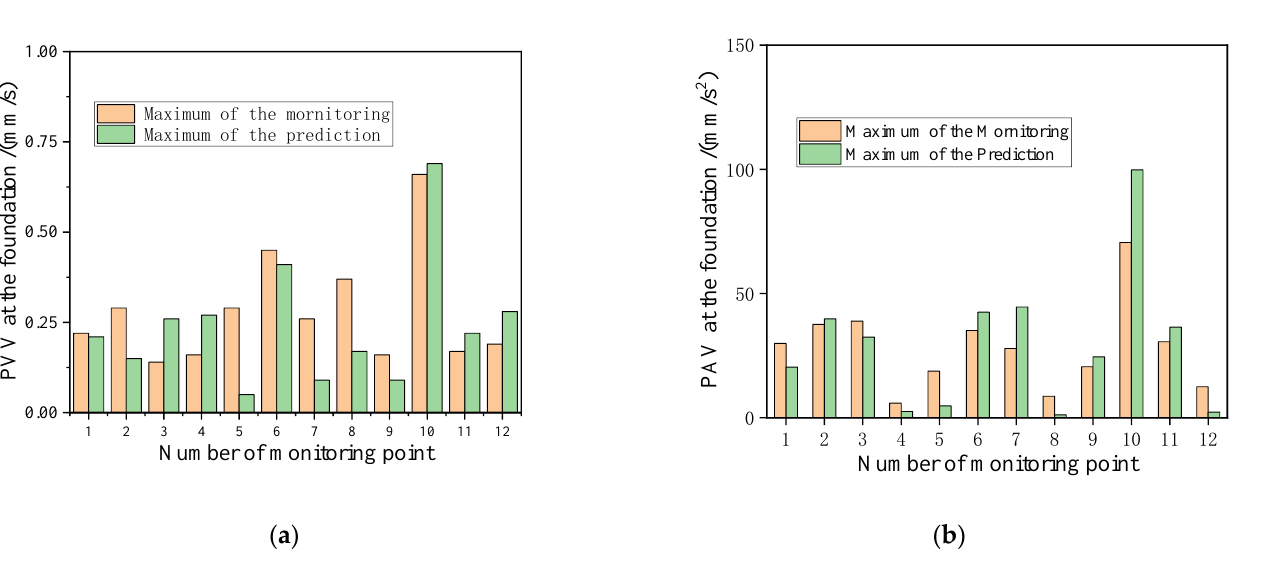
Figure 10. Monitoring and prediction results of vibration response: ( a ) monitoring and prediction results of PVV; ( b ) monitoring and prediction results of PVA.